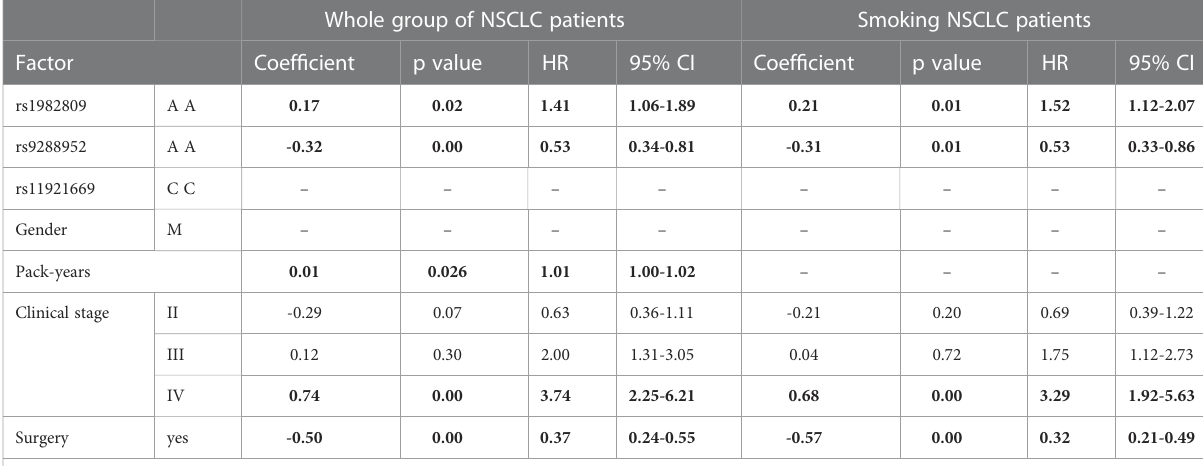
TABLE 7 Multivariate Cox analysis of factors in fl uencing OS for whole group of NSCLC patients and Smoking NSCLC group of